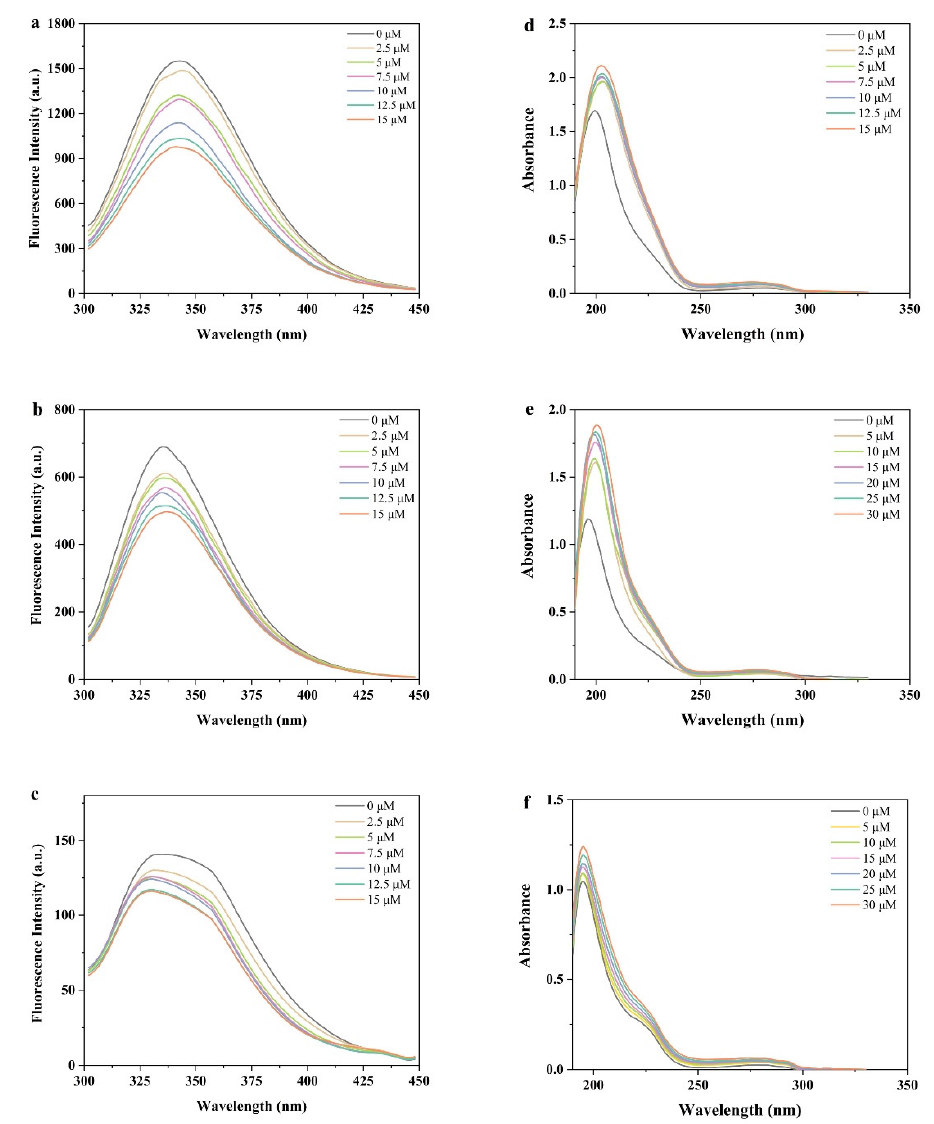
Figure 2. Effect of different concentrations of TF1 on fluorescence spectrum of BSA ( a ), β -Lg ( b ), α -La ( c ) and UV absorption spectra of BSA ( d ), β -Lg ( e ), α -La ( f ) at 298 K and pH 7.4.